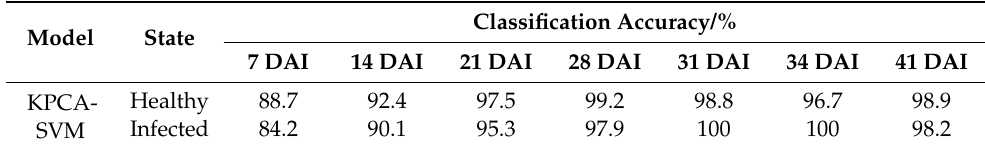
Table 9. Monitoring accuracy of KPCA-SVM based on UAV hyperspectral imagery, at different days after infection (DAI).